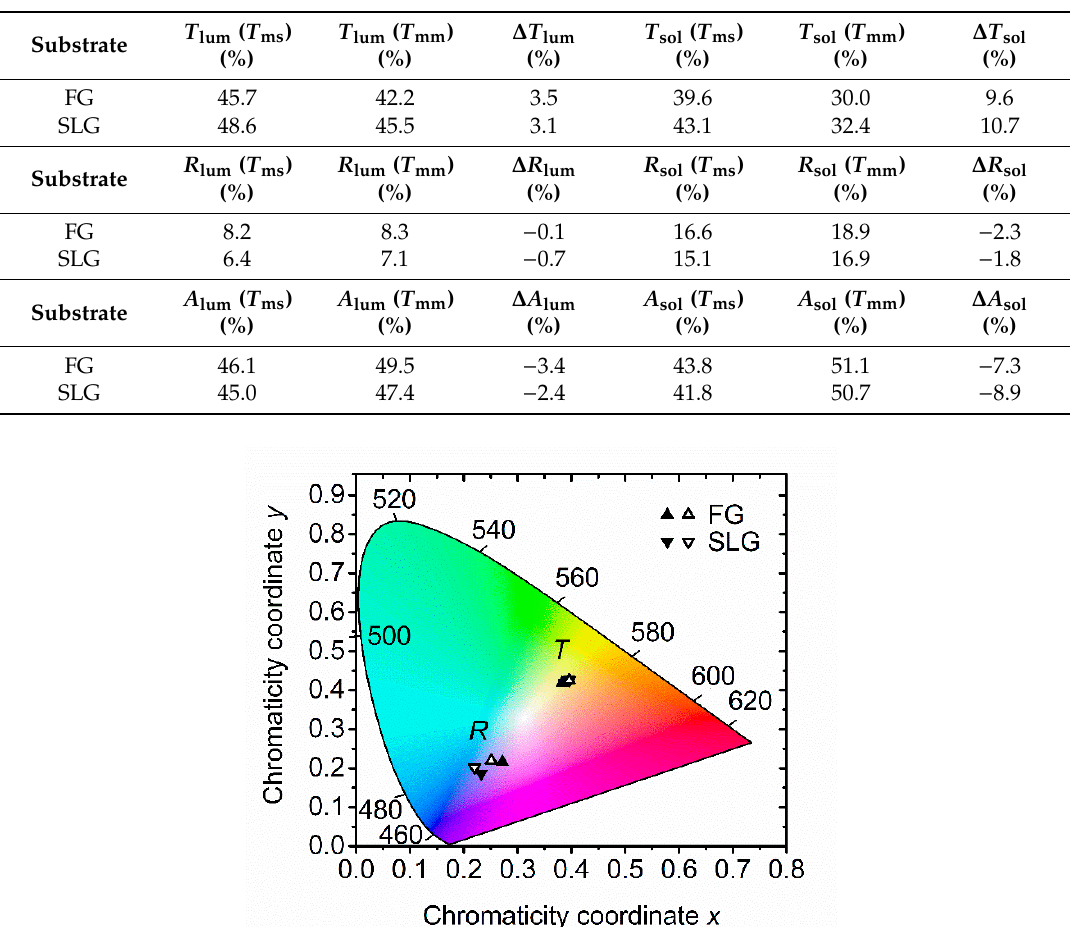
Figure 7. Chromaticity of the coatings shown in the CIE xy chromaticity diagram. There are data below T tr (full symbols) and above T tr (empty symbols), obtained on the ultrathin FG substrate (triangles up) and SLG substrate (triangles down) using the transmittance ( T ) and the reflectance ( R ) presented in Figure 6.